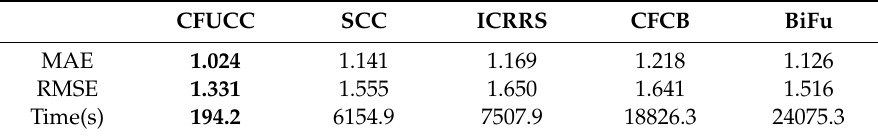
Table 6. Performance comparisons among di ff erent methods for Experiment